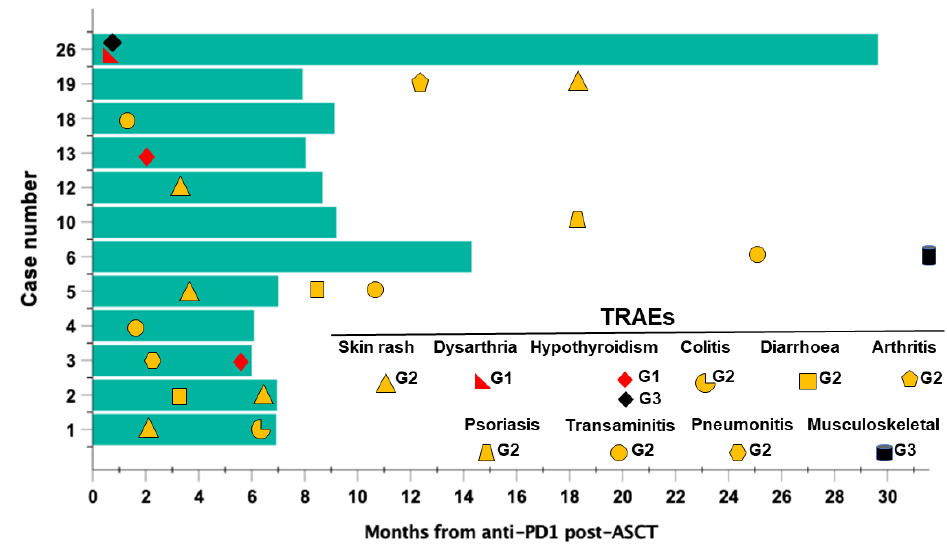
Figure 6. Timelines of occurrence and grading of treatment-related adverse events (TRAEs) registered in patients (n = 12) with high-risk RR-HL during post-ASCT consolidation with PD1-blockade. Bars represent the time (months) of exposure to the anti-PD1 antibody nivolumab. Symbols represent TRAEs grade according to the Common Toxicity Criteria (CTCAE; v. 5.0). The most frequent events included skin rashes (n = 5; 41.7%), transaminitis (n = 4; 33.3%) and thyroid hypofunction (n = 3; 25%). Events were managed according to ESMO guidelines and none led to momentary or permanent treatment discontinuation [30,31]. Seven patients displayed more than one TRAE. Interestingly, in 4 patients, events oc- curred after treatment was discontinued for toxicity-unrelated reasons at a median of 28.6 months (range, 18.6 – 33.3) from the last anti-PD1 dose and after a median of 13 anti-PD1 cycles (range, 10 – 16 cycles) (Figure 6). In all of these patients (namely #19, #10, #6, #5) PD1- blockade was discontinued upon physician decision due to a sustained CR. 4. Discussion To our knowledge, this is the first ‘real - life’ study assessing the safety and effective- ness of PD-1 blockade as a consolidation strategy in patients with RR-cHL at high risk of ASCT failure. Our study population included 73% of patients with ≥3 established risk fac- tors for post-ASCT recurrence and 61% had PET-positive (Deauville ≥ 4) disease before transplant. Treatment was well tolerated, without discontinuations due to toxicity, and we documented a median post-transplant PFS of 42.6 months, with 2-year PFS and OS rates of 79% and 87%, respectively, for the whole cohort. Consolidation started at a median of 44 days from the conditioning regimen, even though, as expected for a real-life study, we had 3 outlier patients with a longer time in- terval. These specific cases had a confirmed PET-negative status early before the start of consolidation, excluding an intercurrent disease progression. One of them recurred after